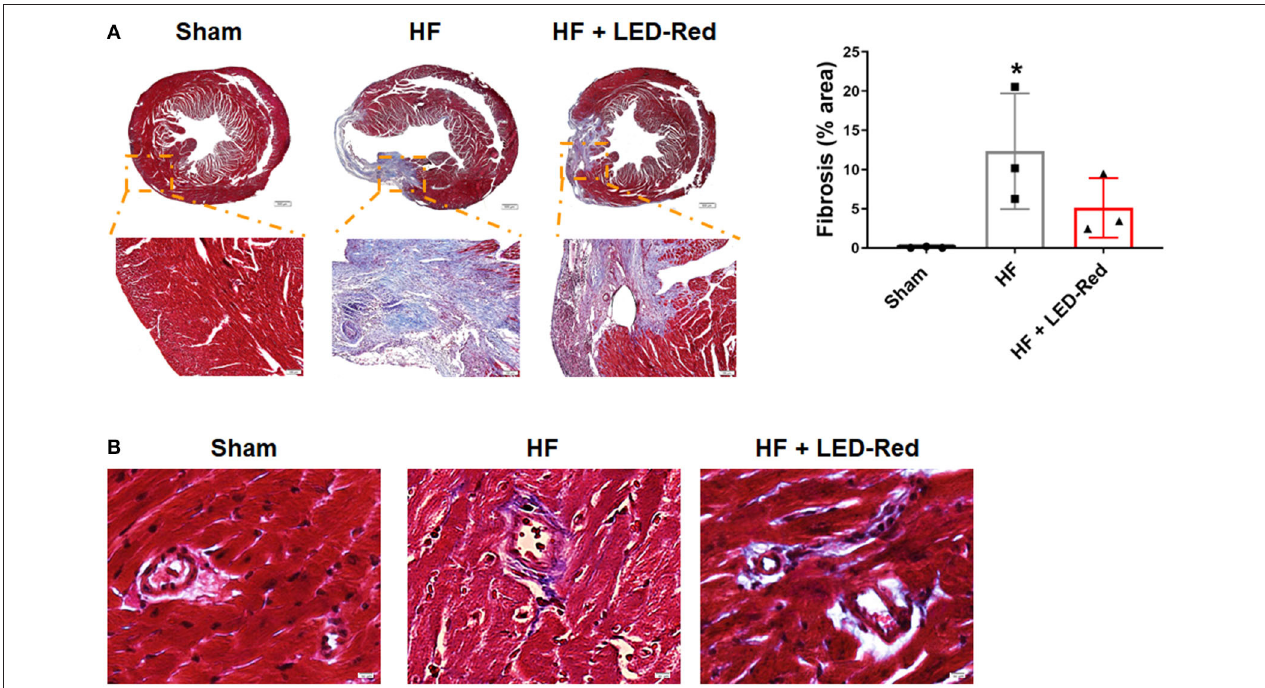
FIGURE 3 | LED-Red therapy reduces fibrosis with heart failure. (A) Fibrosis of mice by Masson staining. Scale bar = 500 µ m (upper panel), 100 µ m (lower panel). (B) The perivascular fibrosis by Masson staining. Scale bar = 50 µ m. n = 3, * P < 0.05 vs. Sham. Data are expressed as the mean ±